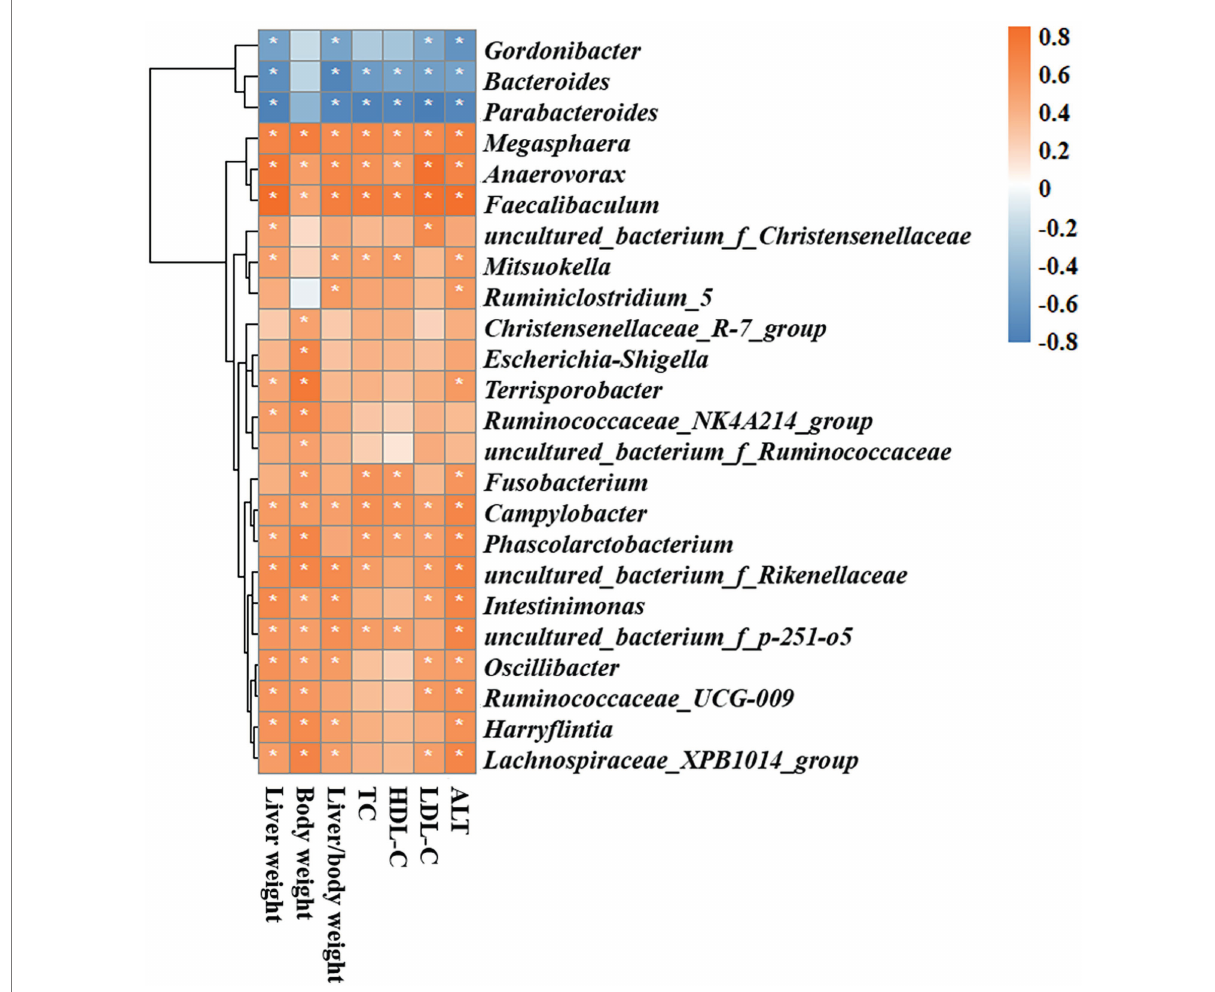
FIGURE 9 Spearman rank correlation analyses of the gut microbiota and MAFLD-related parameters. Red and blue colors indicate positive and negative correlation coefficients, respectively. Significant correlations are indicated by * p <